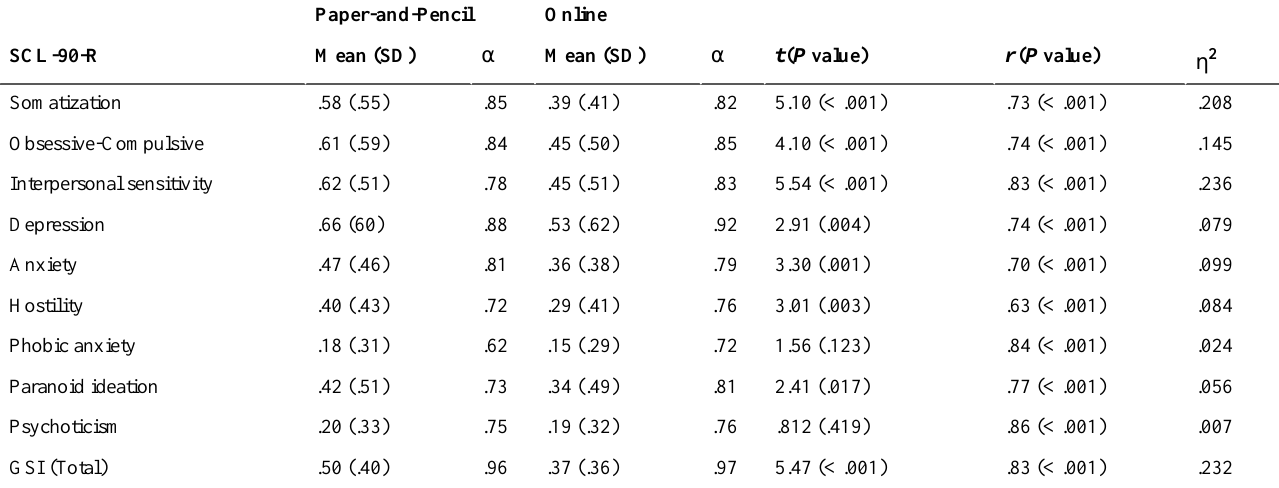
Table 4. SCL-90-R reliability results: Cronbach alpha, mean differences t test, Pearson test-retest correlation, and squared eta effect size